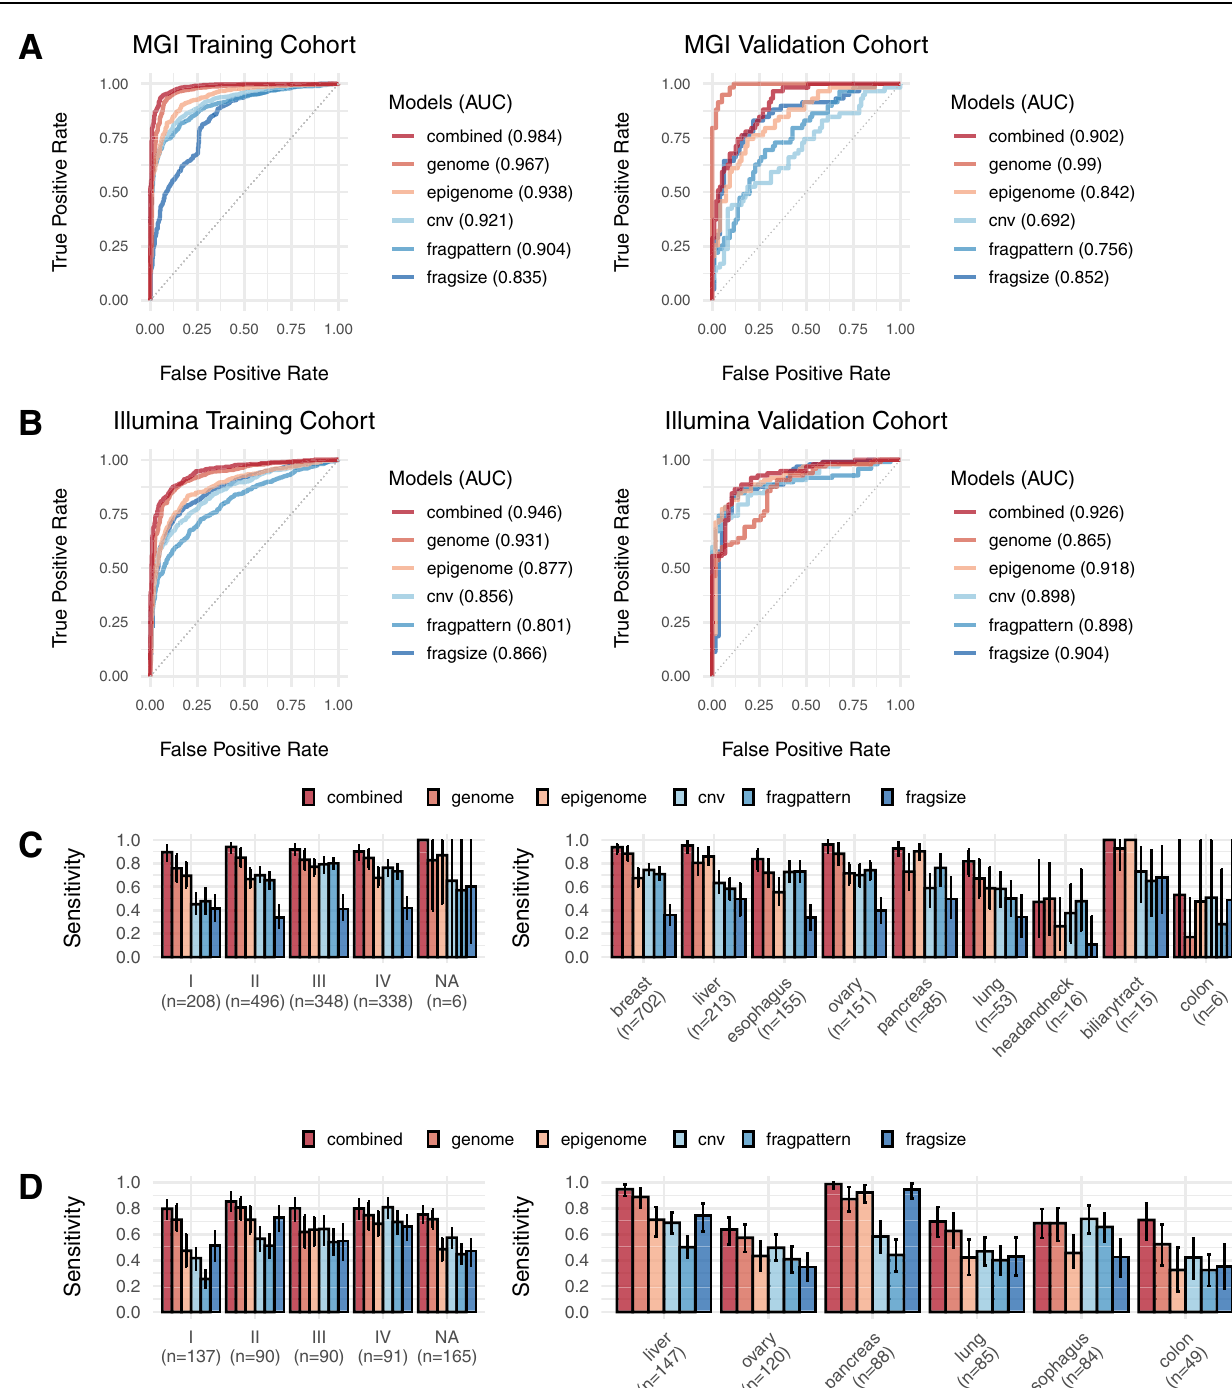
Fig.2|Performanceofcancerdetection.A ROCcurvefordifferentmodelsonthe MGI training cohorts. A total of 1396 cancer and 417 normal control samples were used for training, and 59 cancer and 96 normal control samples were used for validation as the MGI validation cohort. B ROC curve for different models on the Illuminatrainingcohort.Atotalof573cancerand670normalcontrolsampleswere used for training, and 97 cancer and 58 normal control samples were used for validation as the Illumina validation cohort. C , D Sensitivity values with the 95%